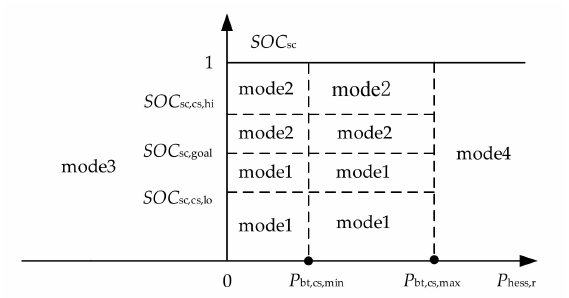
Figure 3. Optimal energy control